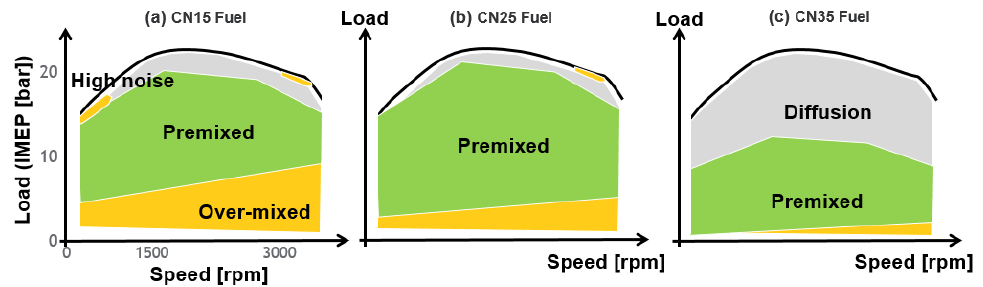
Figure 5. The GCI engine map with benefit and challenge-defined zones by fuel selections: ( a ) CN15, ( b ) CN25 and ( c )